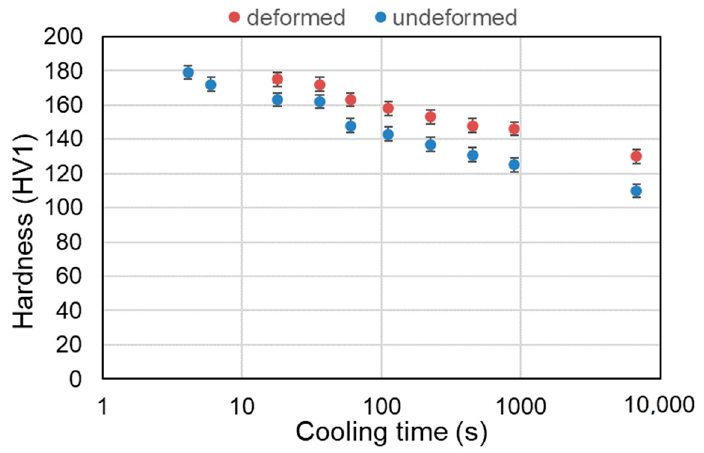
Figure 8. Hardness results for the undeformed and deformed samples cooled at different rates.